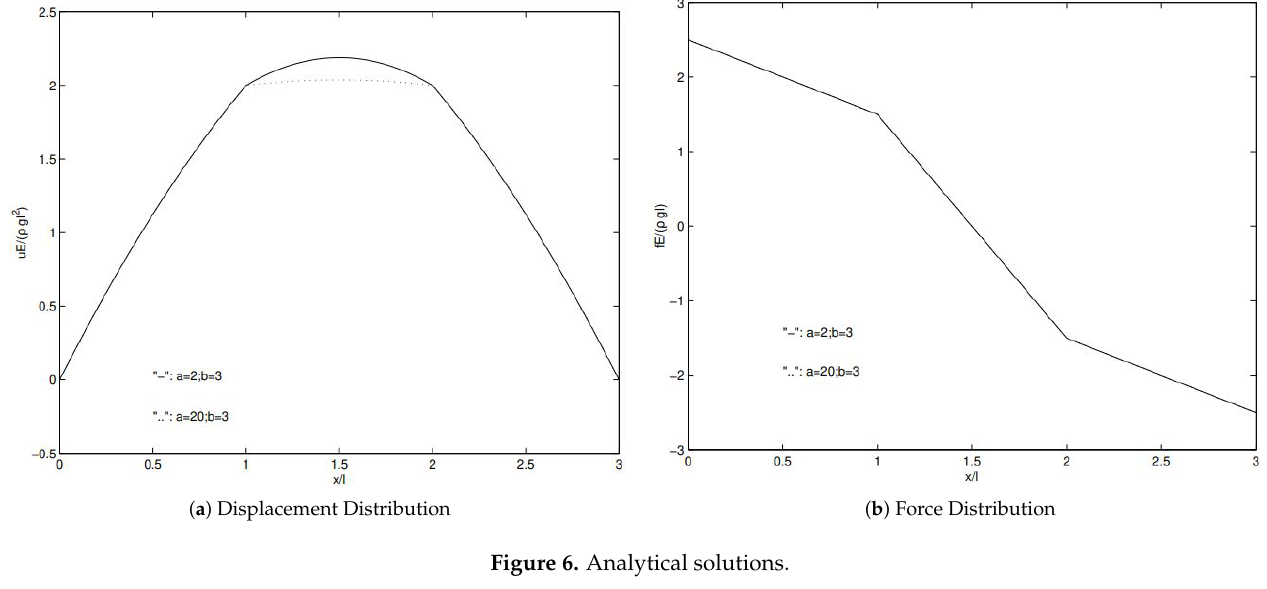
Figure 6. Analytical solutions.